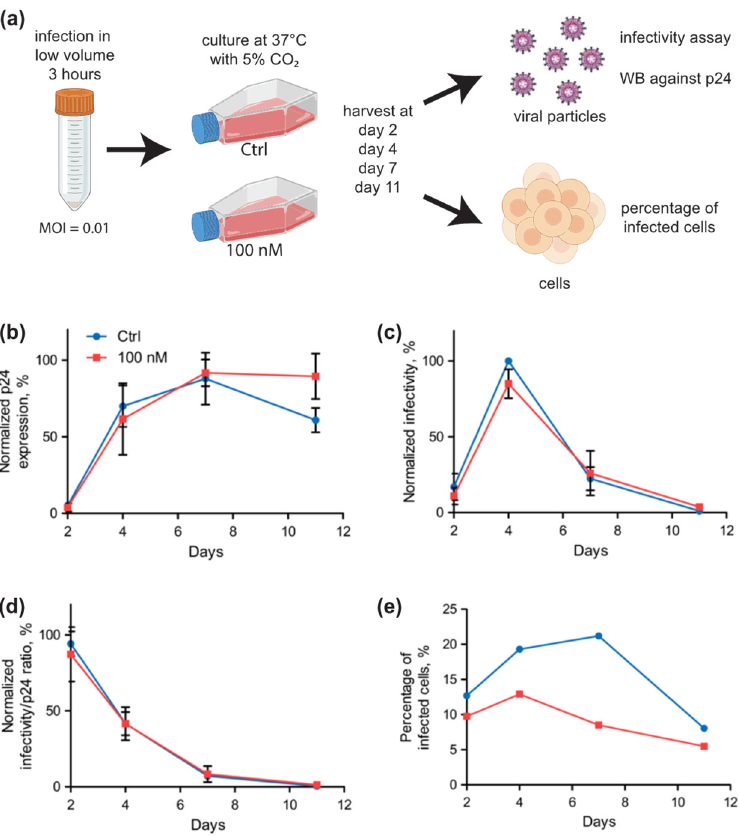
Figure 7. Kinetics of HIV-1 infection of Jurkat cells in control (Ctrl) or 100 nM supplemented conditions. ( a ) Schematic of the experimental procedure used to follow the different parameters of viral production and cell infection during eleven days. The culture media were collected at different time points and analyzed for the levels of HIV-1 p24 capsid protein by Western blot (WB) ( b ) and infectivity of TZM-bl cells ( c ). The anti-p24 Western blots were assessed with biological duplicates, and levels of p24 were expressed relative to the maximum value, arbitrarily set at 100%. The infectivity assays were assessed with biological duplicates in technical triplicates. The maximum value was arbitrarily set as 100%. ( d ) The ratio between infectivity and p24 values were calculated and plotted as a function of time, the maximum value was arbitrarily set as 100%. ( e ) The percentage of infected cell was evaluated in one experiment by immuno-labeling of fixed cells using anti-HIV-1 p24 antibodies coupled with FITC followed by flow cytometry analysis.